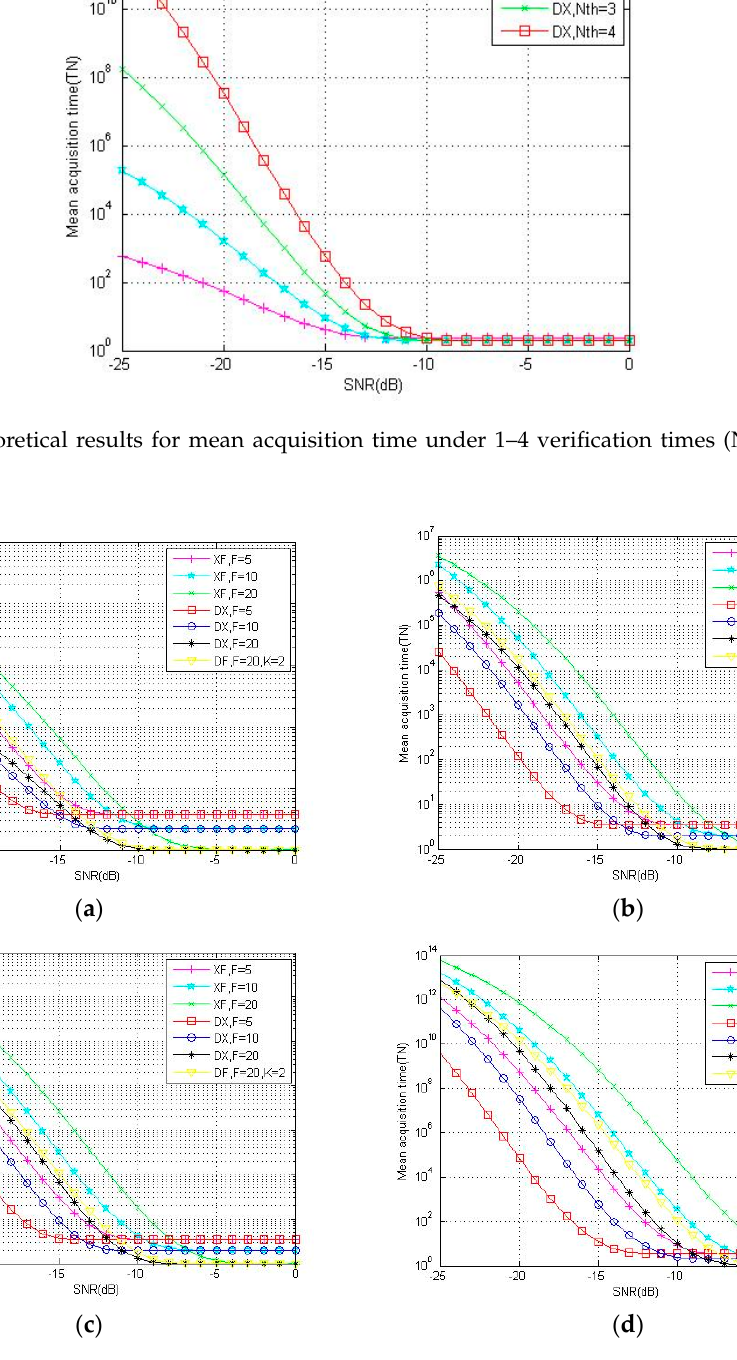
Figure 7. Theoretical results for mean acquisition time of DC-XFAST (“DX”), DF-XFAST (“DF”) and XFAST (“XF”) with N equals to 4096 and N th equals to 1( a ), 2( b ), 3( c ), 4( d